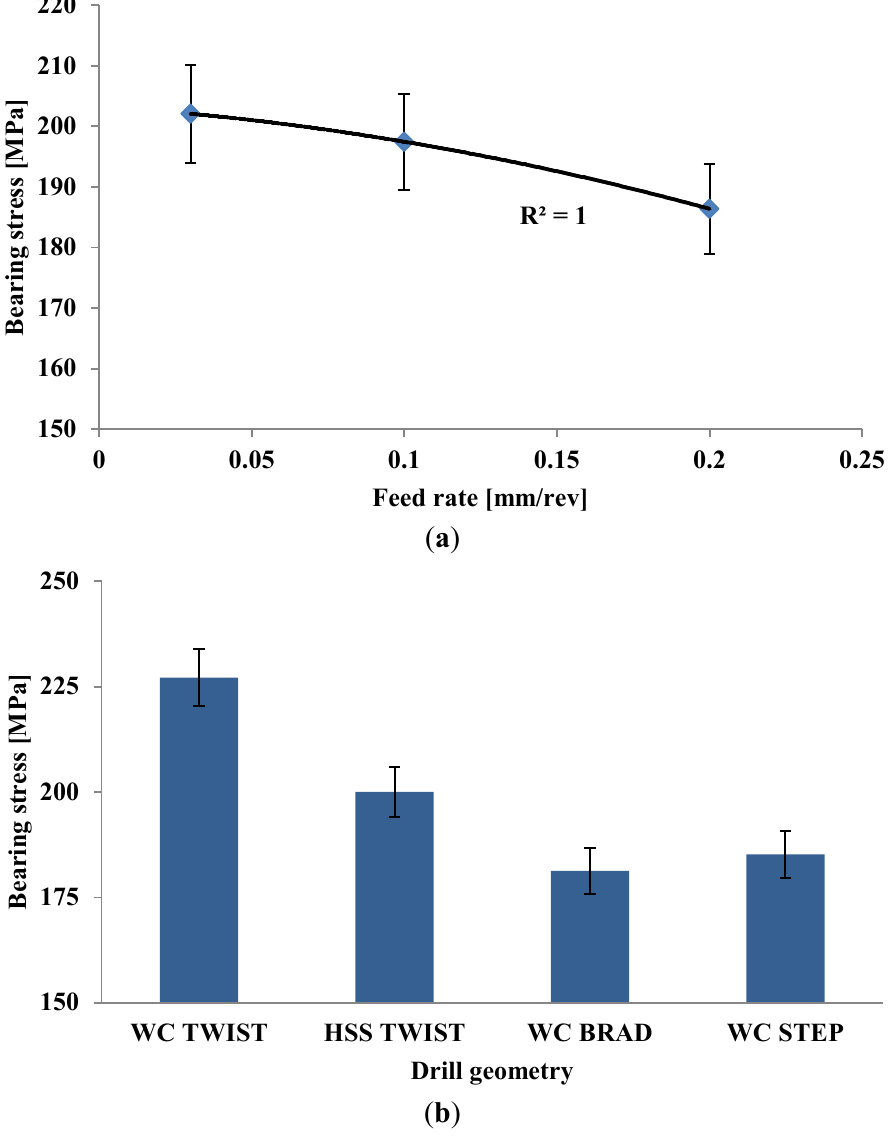
Figure 2. Bearing stress test: ( a ) feed rate effect on the bearing strength; ( b ) drill geometry influence on the bearing